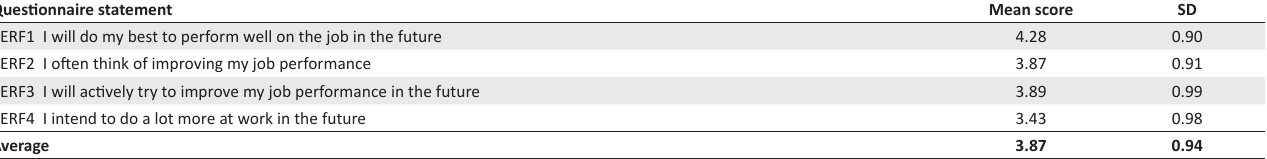
TABLE 4: Job performance intent: Descriptive statistics.